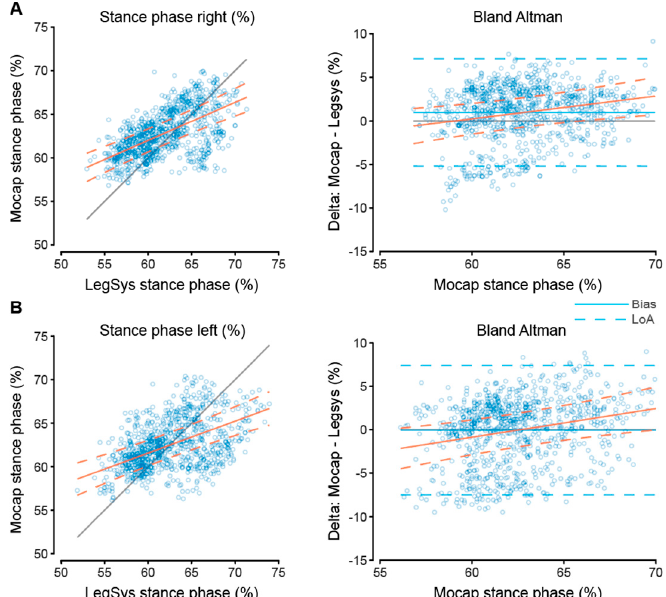
Figure A3. Scatter and bland-Altman plot of MOCAP vs. LEGSYS for right and left stance phase (%). Part ( A , B ) shows the scatter plot and bland-Altman plot on the left and right, respectfully for each parameter. For the scatter plot, the blue dots show right and left stance for each system. The bland-Altman plots show the difference between the MOCAP and LEGSYS parameters on the Y axis and MOCAP right and left stance. Blue line and dotted blue line show the bias and limits of agreement respectfully. The orange line on all 4 plots shows the least squares regression lines with orange dots being the 95% confidence interval.